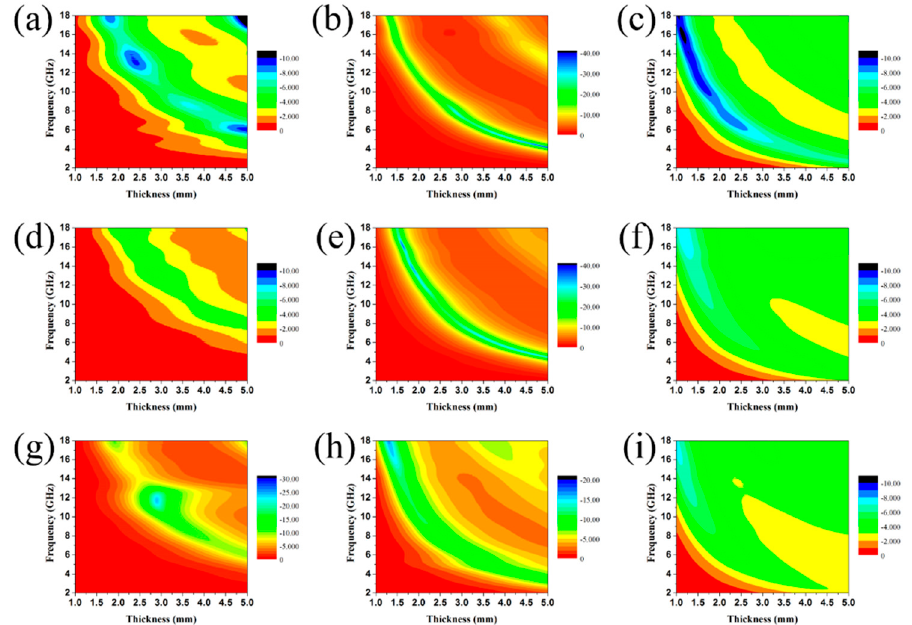
Figure 10. Reflection loss contour maps of the filler loadings of ( a,b,c ) sample A; ( d,e,f ) sample B; ( g,h,i ) sample C, with 20 wt.%, 30 wt.%, and 40 wt.% in wax composites with thicknesses from 1.0 to 5.0 mm in the frequency range of 2–18 GHz.